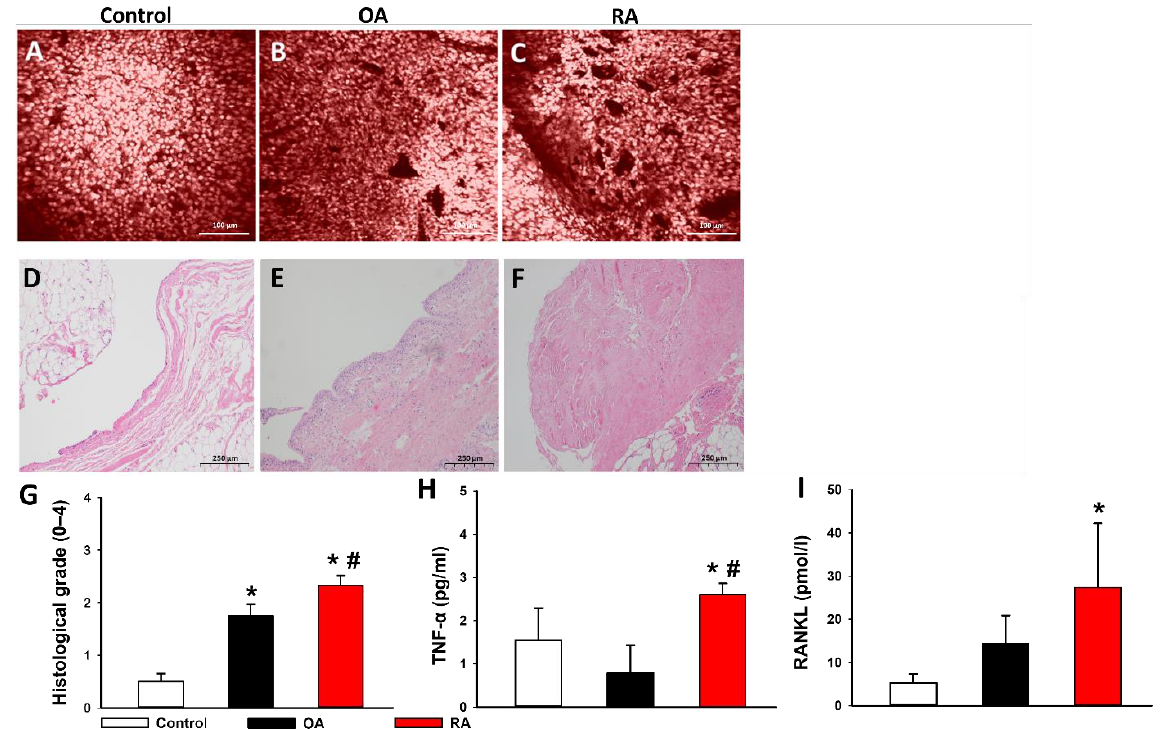
Figure 4. Histological changes and inflammatory cytokines in the synovium. ( A – C ) Tissue sections show the results of in vivo confocal laser scanning endomicroscopy with acriflavine labeling. The bar represents 100 μm. ( D – F ) Histological sections stained with hematoxylin and eosin. ( A ) Healthy synovium with rounded synoviocytes. No signs of inflammation-related angiogenesis and fibrosis can be seen. ( B ) Osteoarthritic synovium with moderate angiogenesis due to low-grade chronic inflammation. ( C ) Synovium of a patient suffering from RA. The large number of vascular cross-sections refers to inflammation-related angiogenesis. Scarring occurs as a result of chronic synovitis. ( D ) Joint capsule section with synovial membrane from a healthy joint. Flattened mast cells constitute a single cell layer. The lamina propria is poor in cells and rich in connective tissue fibers. Adipocytes and cross-sections of capillaries can be observed in the deeper layers. ( E ) Joint capsule sample from osteoarthritic joint. The synovial membrane is thickened, consists of 3 – 4 cell layers. Increased cellularity occurs, partly due to the mild lymphocytic infiltration that can also be observed in the lamina propria. ( F ) Joint capsule sample of a patient suffering from RA. As a result of extensive scarring, the synovial membrane is unrecognizable. Fibrosis affects more than 50% of the stroma. ( G ) Histological grading is performed by allocating a composite number to the groups based on the extent of angiogenesis and fibrosis (0 – 4 grade). ( H ) TNF- α levels in the synovial fluid . ( I ) RANKL levels in the synovial fluid. RA group is marked with red. Black represents the OA group. The control group is marked with white. Data are presented as means ± SD. * p < 0.05 vs. control; # p < 0.05 vs. OA (one- way ANOVA, Tukey’s test ). TNF- α = T umor Necrosis Factor- α, RANK L = Re-